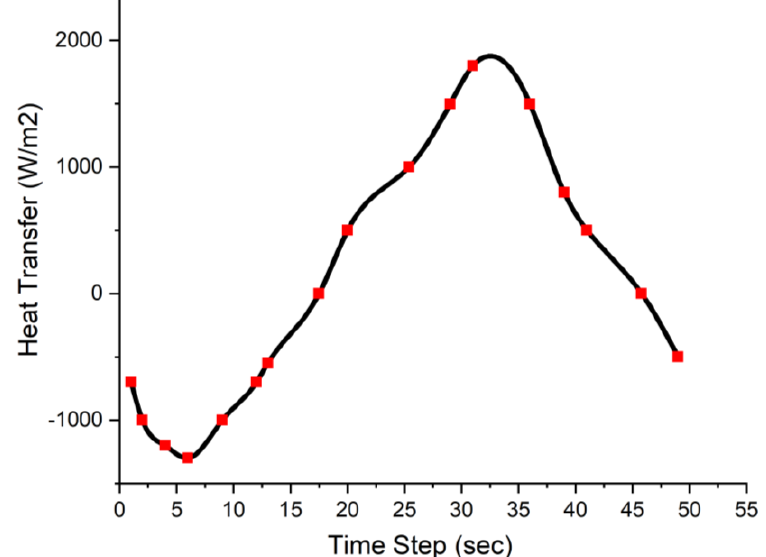
Figure 10. Rate of heat transfer over a cycle at CHX for case #5.